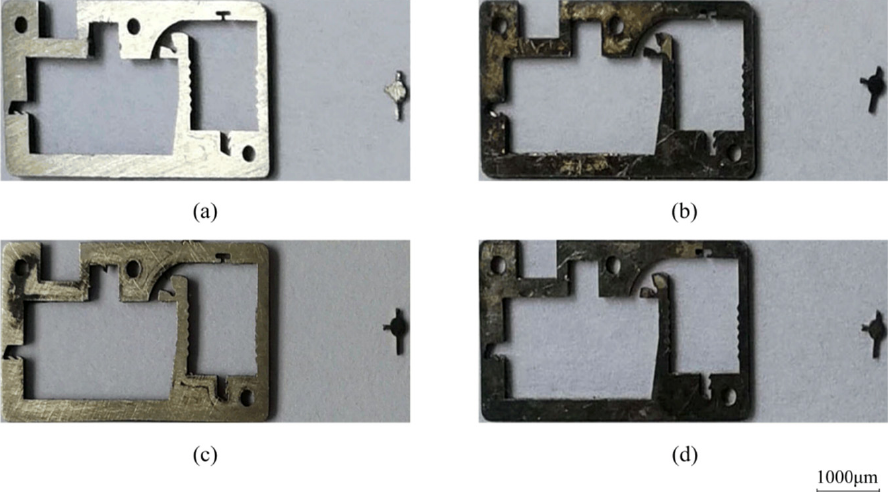
Figure 23. Test results of pin pusher. ( a ) #1; ( b ) #2 ; ( c ) #3; ( d ) #4.